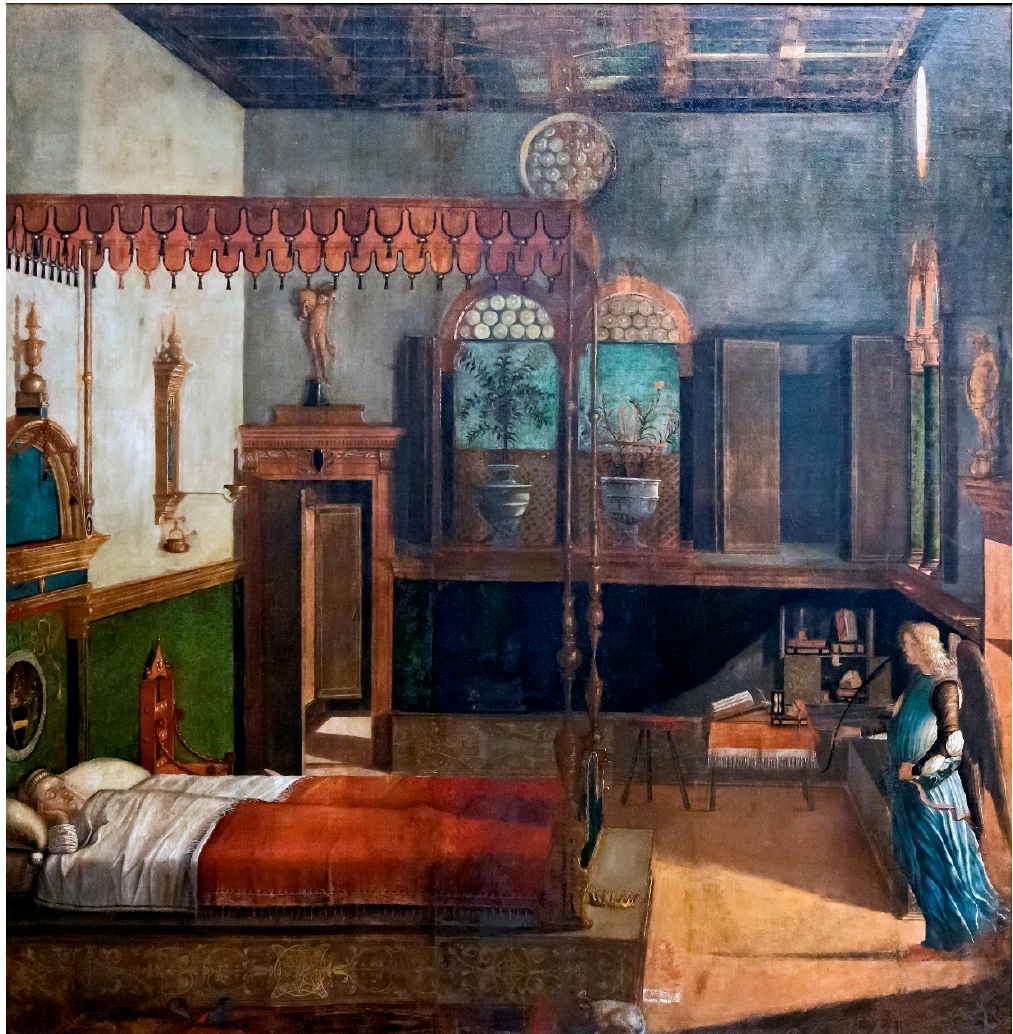
Figure 12. Vittore Carpaccio, The Dream of Saint Ursula , ca. 1495, Venice, Gallerie dell’Accademia (image in the public domain).